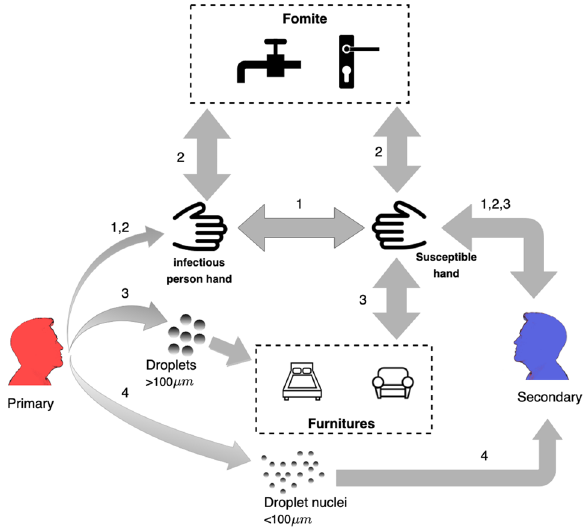
Figure 1. Schematic representation of the modes of transmission from the primary (infector) and secondary (infectee) individuals. (1) Direct contact (2) Indirect contact via fomites (3) Indirect contact via surfaces (4) droplet